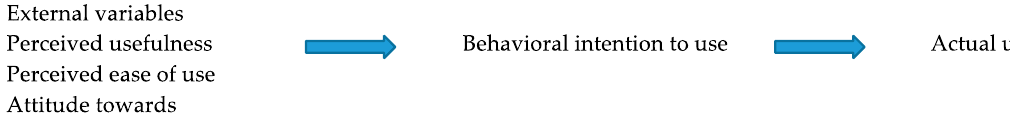
Figure 1. The main variables of the Technology acceptance model (TAM), adapted after [28].